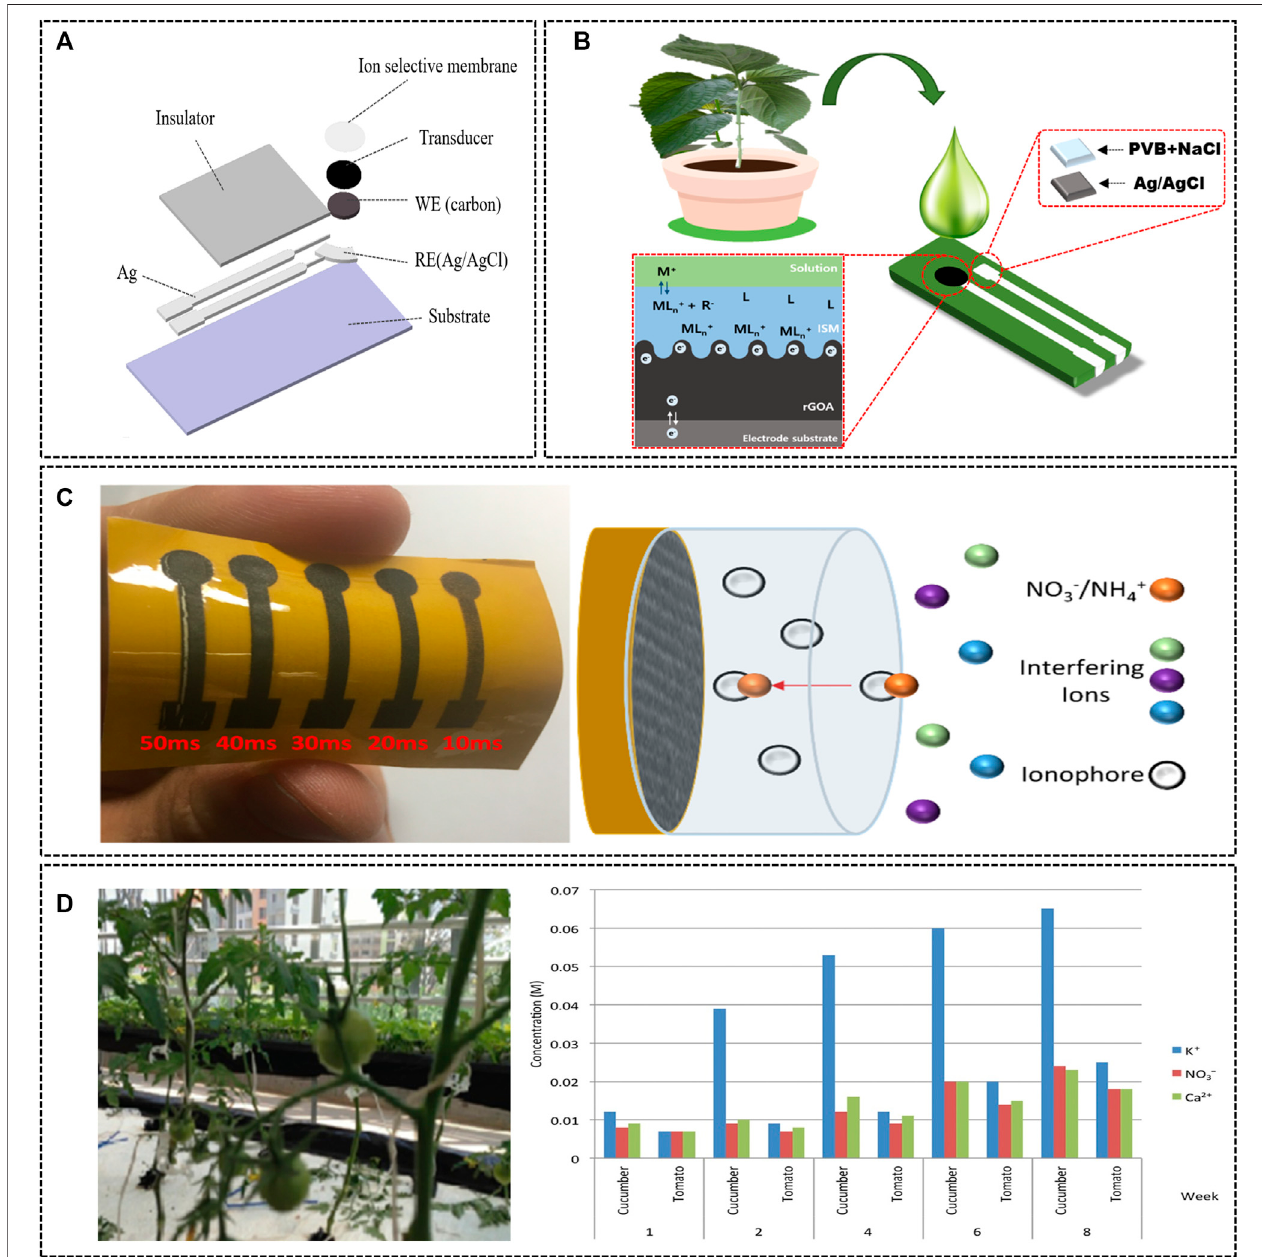
FIGURE 4 | (A) Schematic representation of the SC-ISE based SPE (M.-Y. Kim et al., 2021). Copyright © 2021 (Elsevier). (B) Reduced graphene oxide aerogel- based SC-ISE for Ca 2+ and NO 3 − detection in the plant sap (M.-Y. Kim et al., 2021). Copyright © 2021 (Elsevier). (C) Laser-induced graphene-based SC-ISE for the determination of NO 3 − and NH 4+ levels in the soil sample (Garland et al., 2018). Copyright © 2018 (American Chemical Society). (D) The hydroponic greenhouse control systems (left) and mineral uptake by cucumber and tomato plants in nutrition reservoirs (right) (Vardar et al., 2015). Copyright © 2015